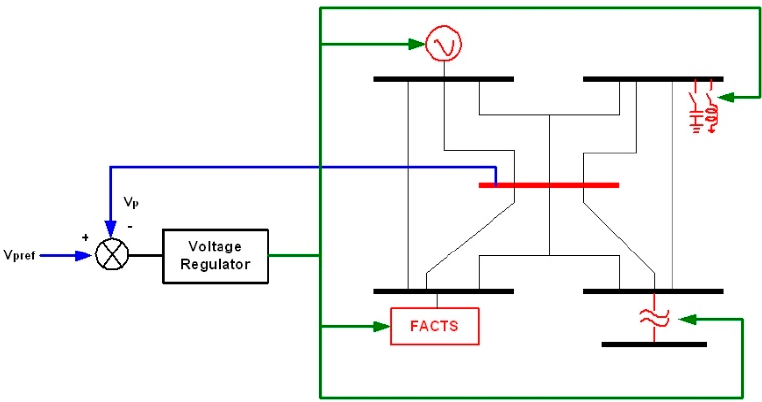
Figure 1. Secondary voltage regulation concept.